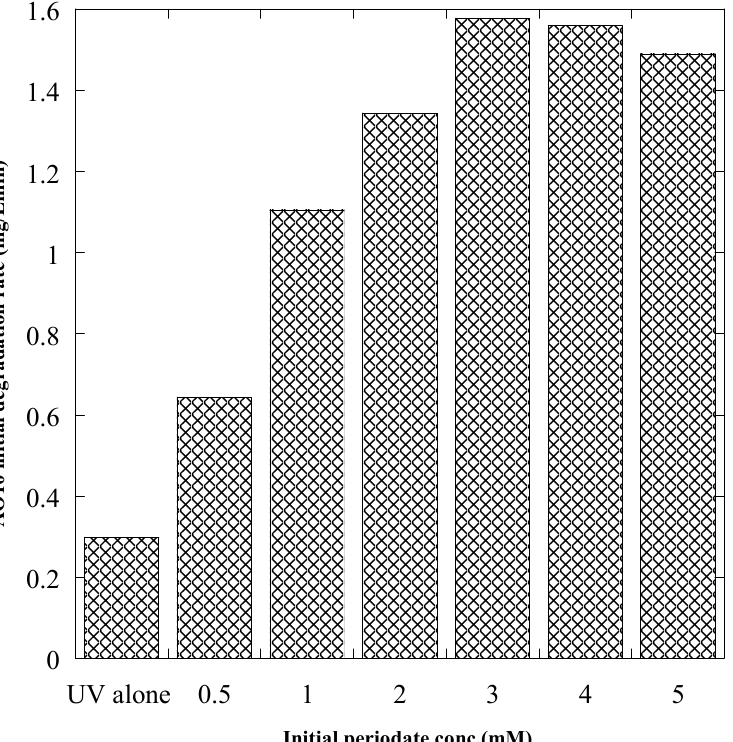
Figure 4. Effect of the [IO 4– ] on the initial degradation rate of AO10 ([AO10] 0 = 50 mg/L, 20 ± 1 °C, initial pH 5.4, irradiation intensity: 15 mW/cm²).